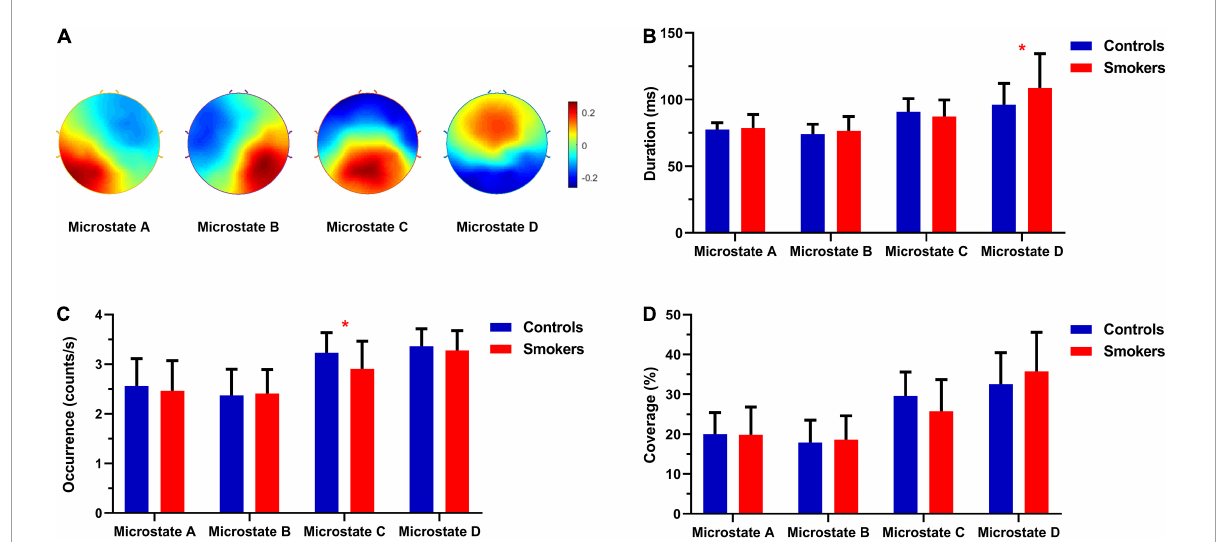
FIGURE1 (A) The topographies of the four microstate classes that were calculated based the aggregated dataset from all participants. (B) The differences in the microstate duration between young smokers and non-smoking controls. (C) The differences in the microstate occurrence between young smokers and non-smoking controls. (D) The differences in the microstate coverage between young smokers and non-smoking controls. *Indicated significant difference ( p < 0.05).